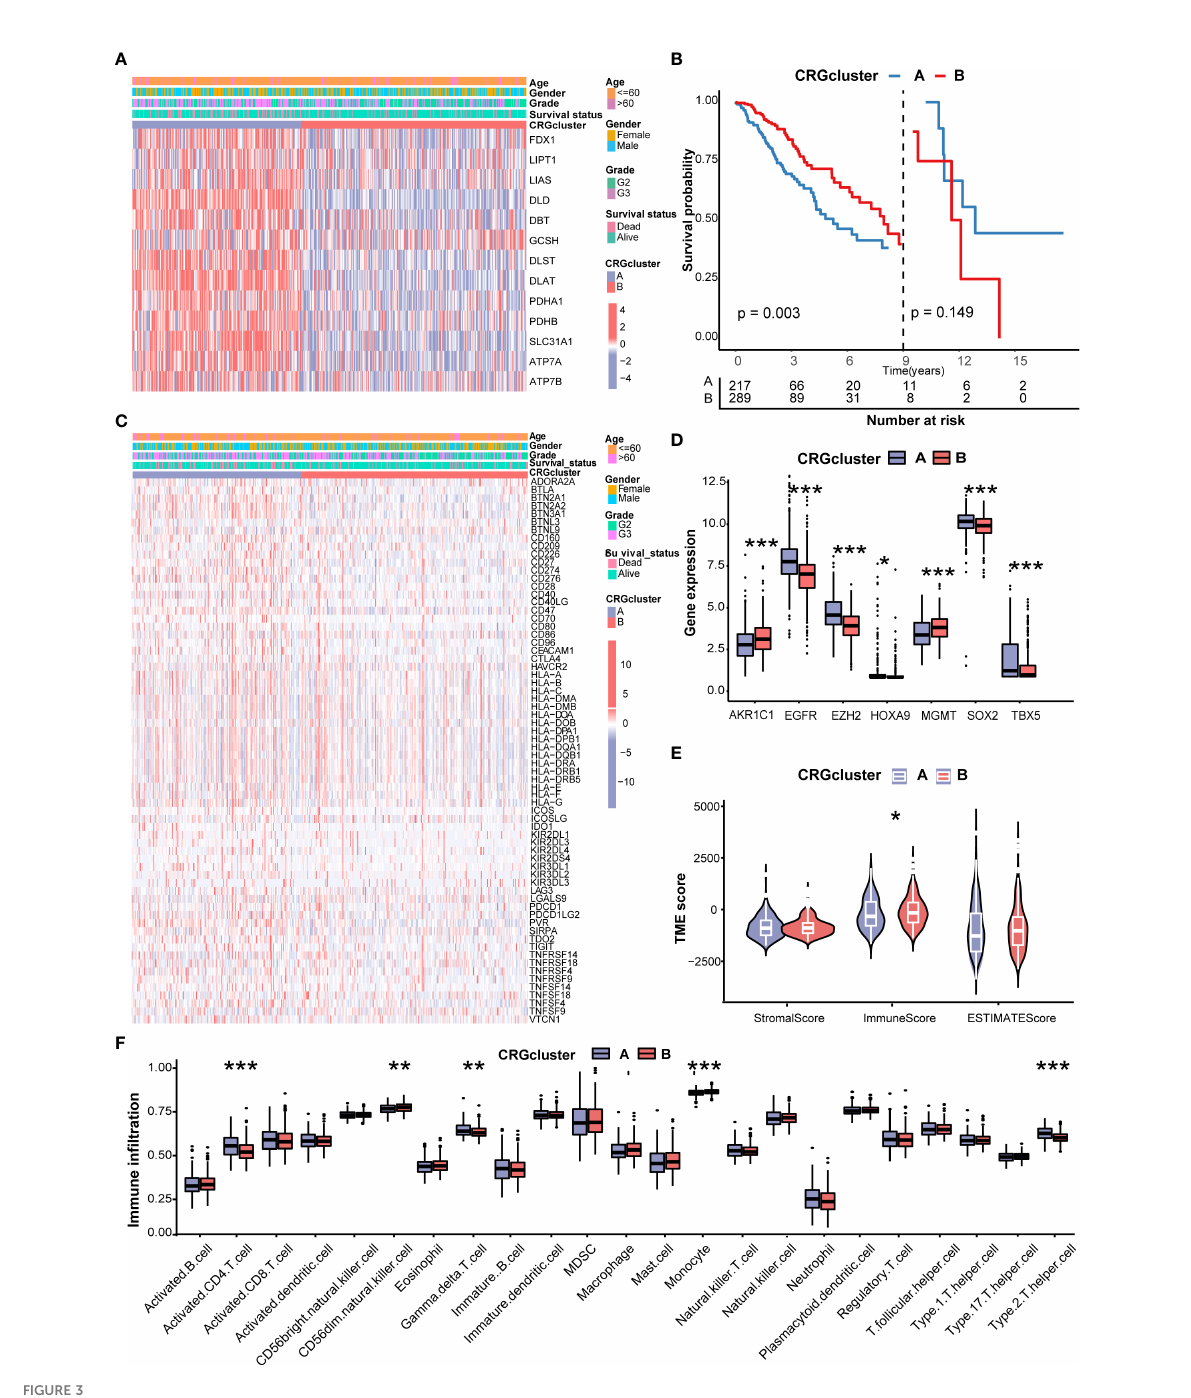
FIGURE 3 Correlations of CRG clusters with clinical features, CRSGs, immune checkpoint genes (ICGs), and tumor microenvironment (TME). (A) The heatmap showed the different expressions of CRGs and clinicopathological characteristics between CRG cluster A and (B) (B) Landmark survival analysis for two CRG clusters. The overall survival probability of LGG patients in the two CRG clusters was calculated by Kaplan – Meier analysis (log-rank tests). A landmark time of 9 years was set. (C) The heatmap showed the different expressions of ICGs and clinicopathological characteristics between CRG cluster A and B (D) Differences in the expression levels of seven chemoradiotherapy sensitivity – related genes (CRSGs) between CRG cluster A and B (E) Correlations between the two CRG clusters and TME scores. (F) Differences in the abundance of in fi ltrating immune cells between CRG cluster A and B (CRG cluster A, blue; CRG cluster B, red) P values were shown as: * P <0.05; ** P <0.01; *** P <0.001. CRGs, cuproptosis-related genes; CRSGs, chemoradiotherapy sensitivity – related genes; ICGs, immune checkpoint genes; TME, tumor microenvironment; LGG, lower-grade glioma (WHO II and